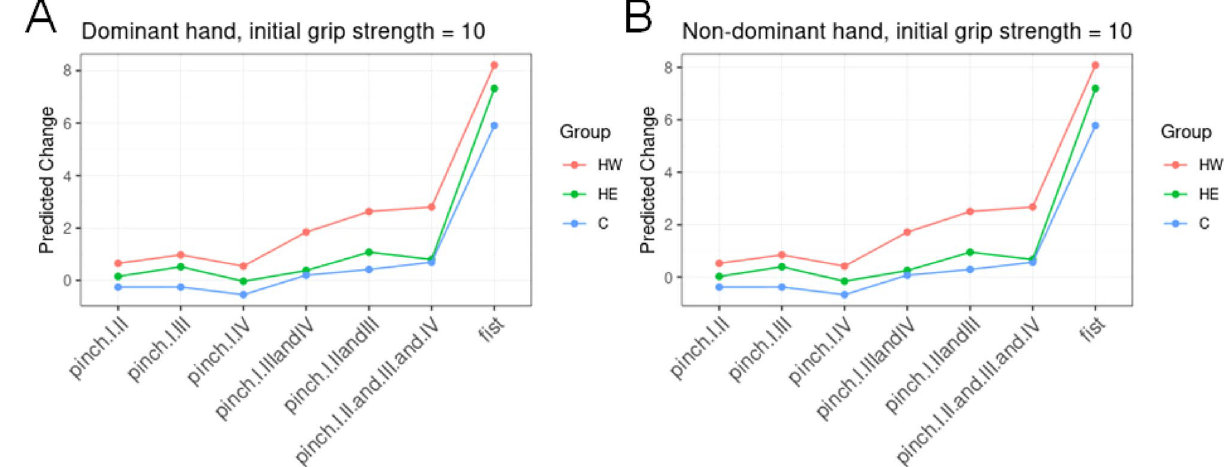
Figure 2. Expected grip strength improvement for each training group. For an initial grip strength of 10 kg in the pinch I/II, the predicted values for each pinch and all three groups are represented within the ( A ) dominant and ( B ) non-dominant